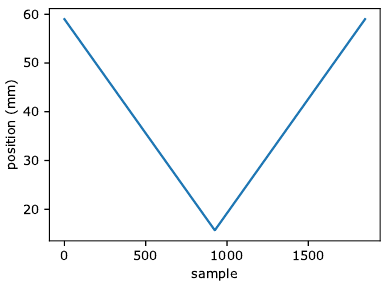
Figure 8. The permanent magnet position in the measurement of